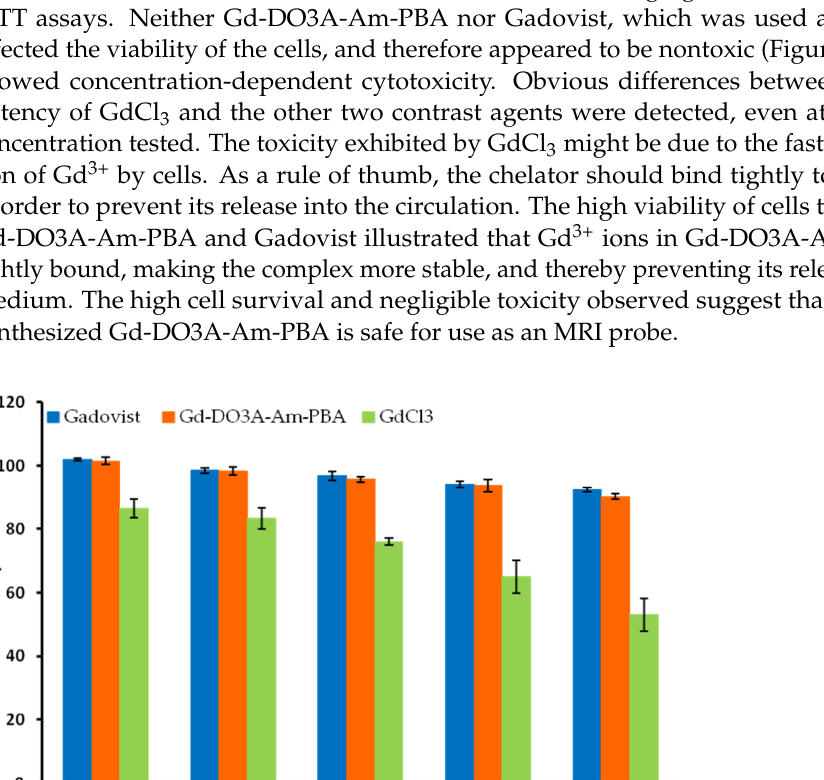
Figure 3. ( A ) Measured 1/ T 1 NMRD profiles of Gd-DO3A-Am-PBA (black), Gadovist (red), and GdCl 3 (blue) with 2 μ mol of gadolinium. ( B ) Measured 1/T 1 NMRD profiles of freshly prepared (red) and three months (blue) and six months (purple) room temperature stored Gd-DO3A-Am-PBA. All measurements were made in pure water, pH 7, at 25 °C.